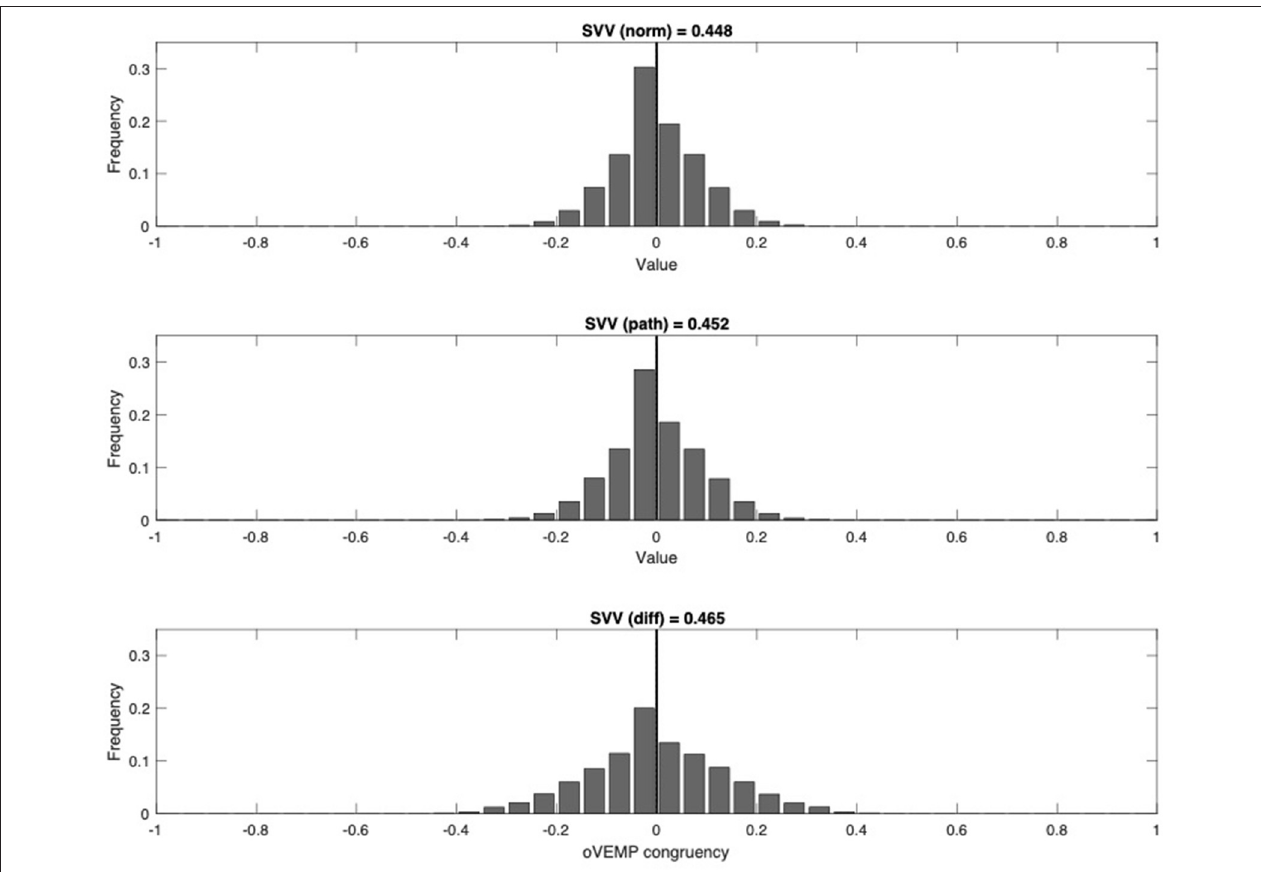
TABLE 2 | Cross table of SVV and BCR. BCR Tilt to the left Normal Tilt to the right SVV Tilt to the left % of SVV (n) 51.9% (14) 44.4% (12) 3.7% (1) Normal % of SVV (n) 17.5% (11) 77.8% (49) 4.8% (3) Tilt to the right % of SVV (n) 0.0% (0) 55.6% (5) 44.4%